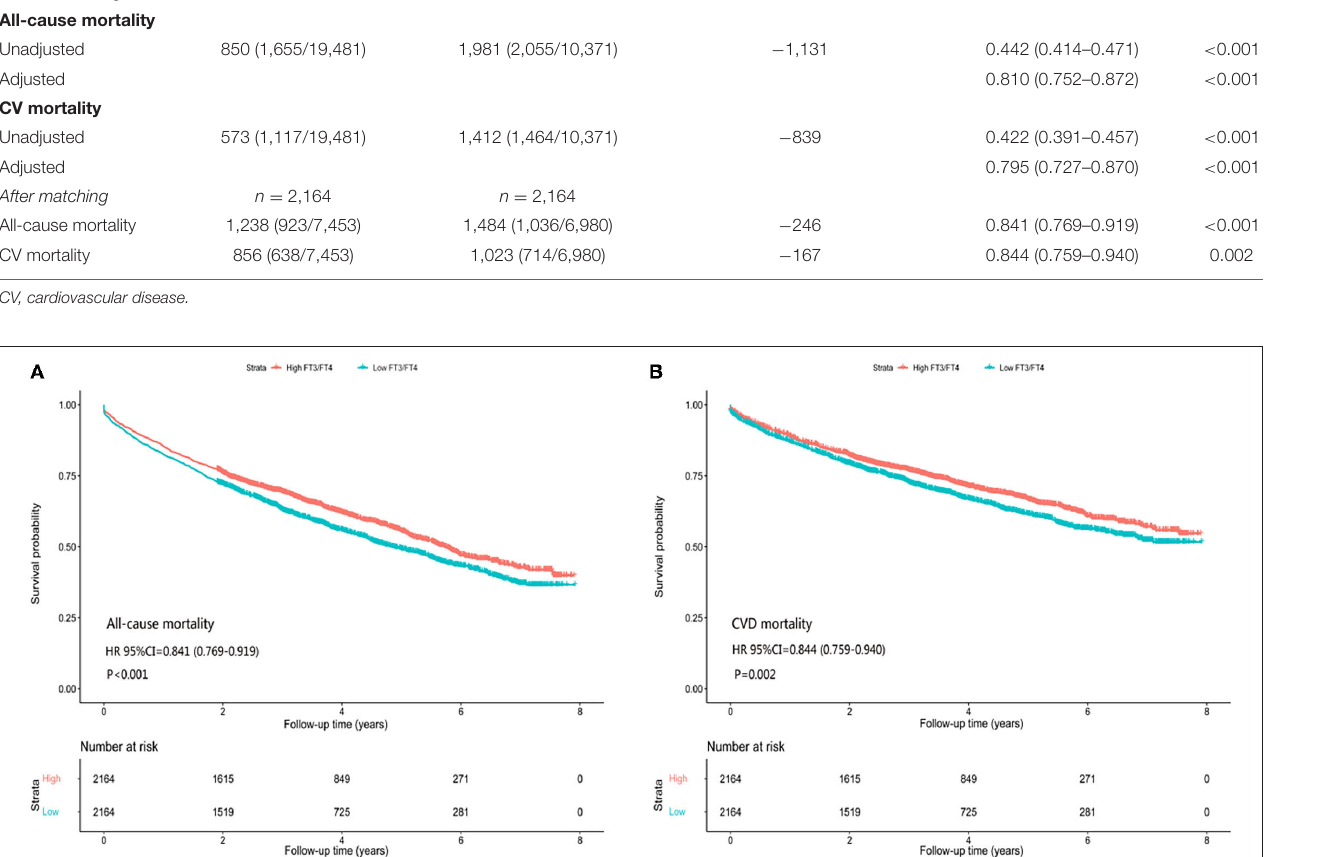
all-cause and CV mortality in patients with HF could be predicted independently using a low FT3/FT4 ratio. Specifically, the hazard ratio of long-term all-cause mortality for patients with a high FT3/FT4 ratio was 0.841 times less than that in patients with a low FT3/FT4 ratio. This was similarly seen in CV mortality, with a value of